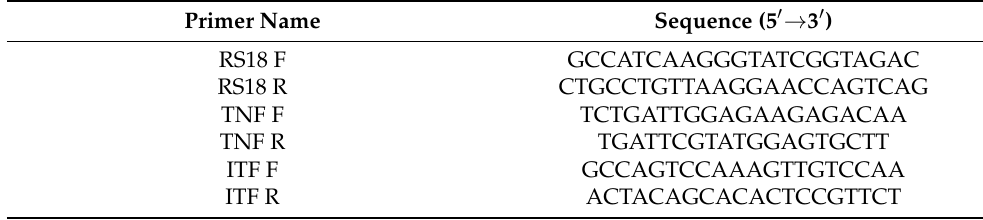
Table A1. Primer sequences used for